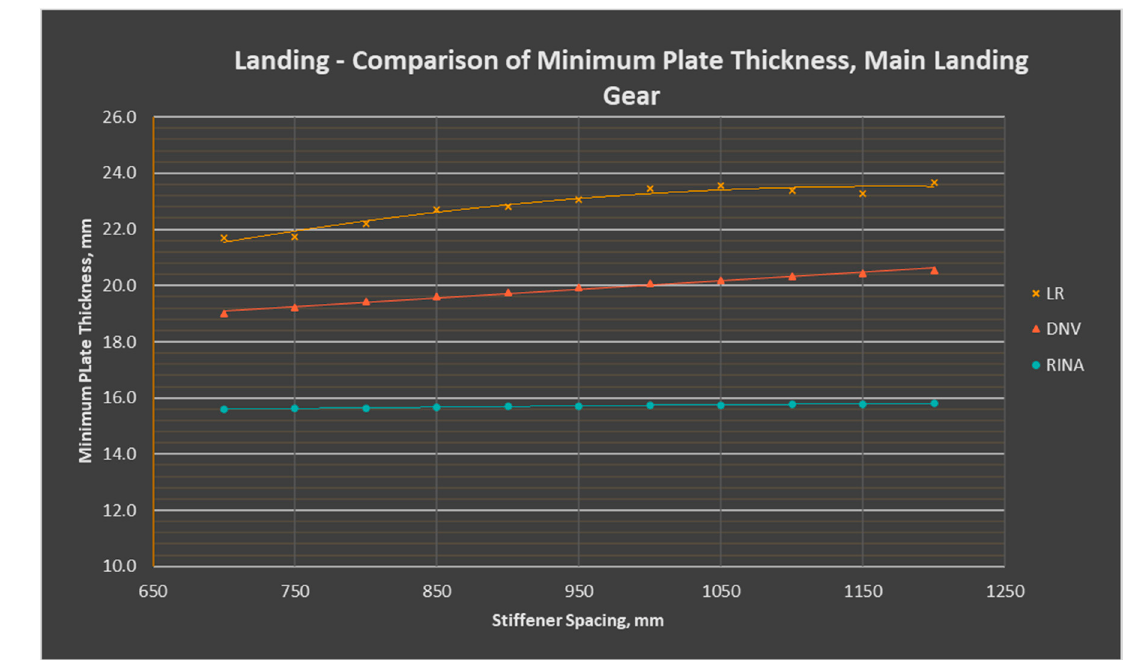
Figure 2. Variations in minimum deck plate thickness as a function of stiffener spacing required for the landing condition.